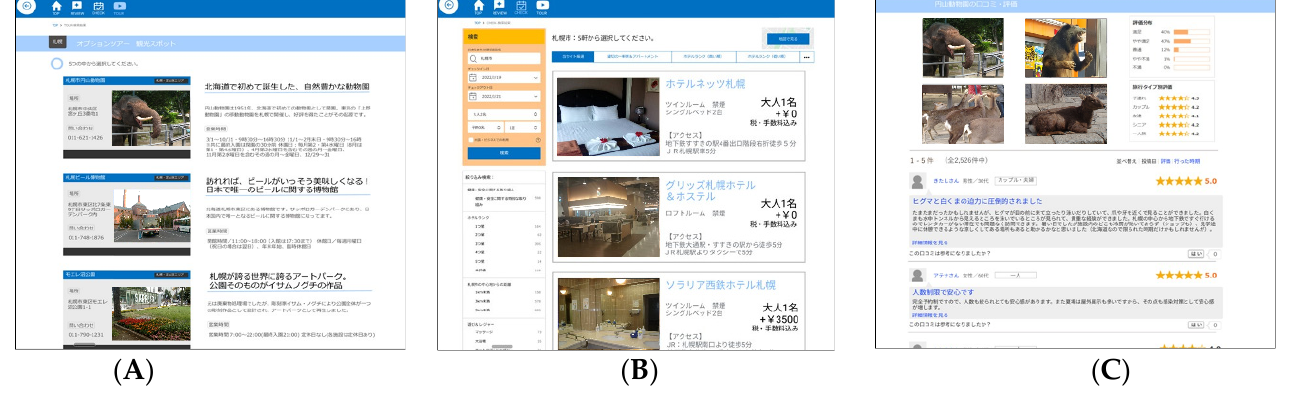
Figure 10. Examples of the interface of the travel agency website. ( A ) Task A: Tour finding; ( B ) task B: Hotel finding; ( C ) task C: Information review.